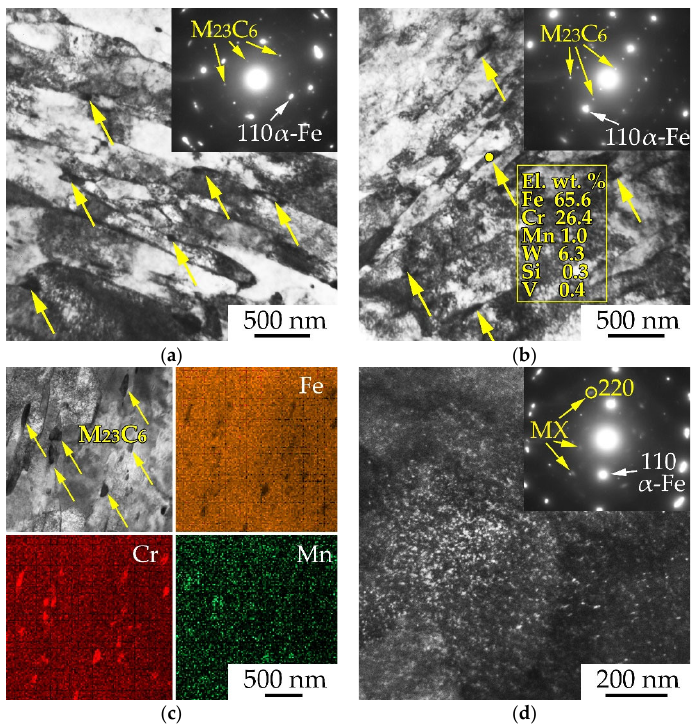
Figure 8. TEM images of steel microstructure after THT ( a ) and HTMT in a section parallel to the rolling plane ( b – d ): bright field (BF) images ( a , b ) with the corresponding micro diffraction (MD) patterns, scanning transmission electron microscopy (STEM) image with EDX elemental maps ( c ), dark field (DF) image in the reflection of MX ‐ type carbonitrides ( d ).